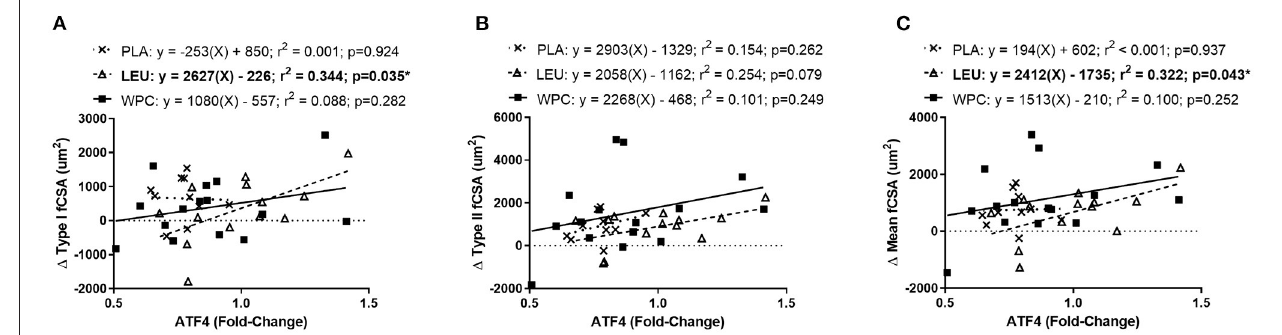
FIGURE 4 | The change in ATF4 protein predicts the change in fCSA only in LEU following 12 weeks of resistance exercise training. Regression analysis was completed using the change in ATF4 protein to predict the change in Type I (A) , Type II (B) , and mean (C) fCSA. Each panel contains each group’s predictive equation, coefficient of determination ( r 2 ), and p -value. Best fit lines are displayed in each graph. *A significant prediction. Sample size for each group is PLA = 12, LEU = 13, and WPC =